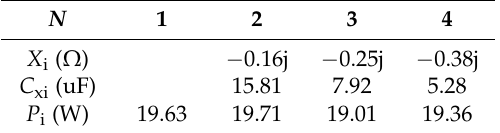
Table 3. The values of compensating capacitance required for different numbers of loads.